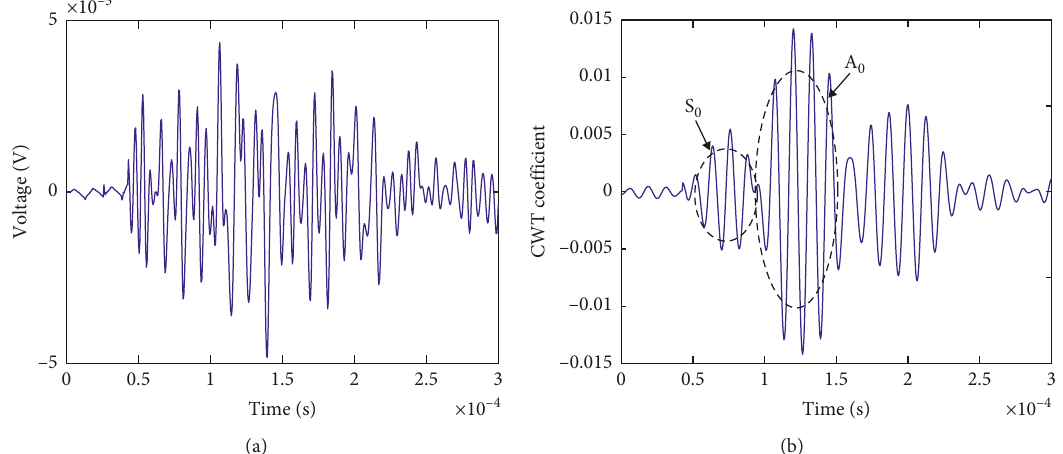
Figure 7: Lamb wave signal acquired by the piezoelectric fiber at 80kHz: (a) averaged after 100 times; (b) CWT coefficients at